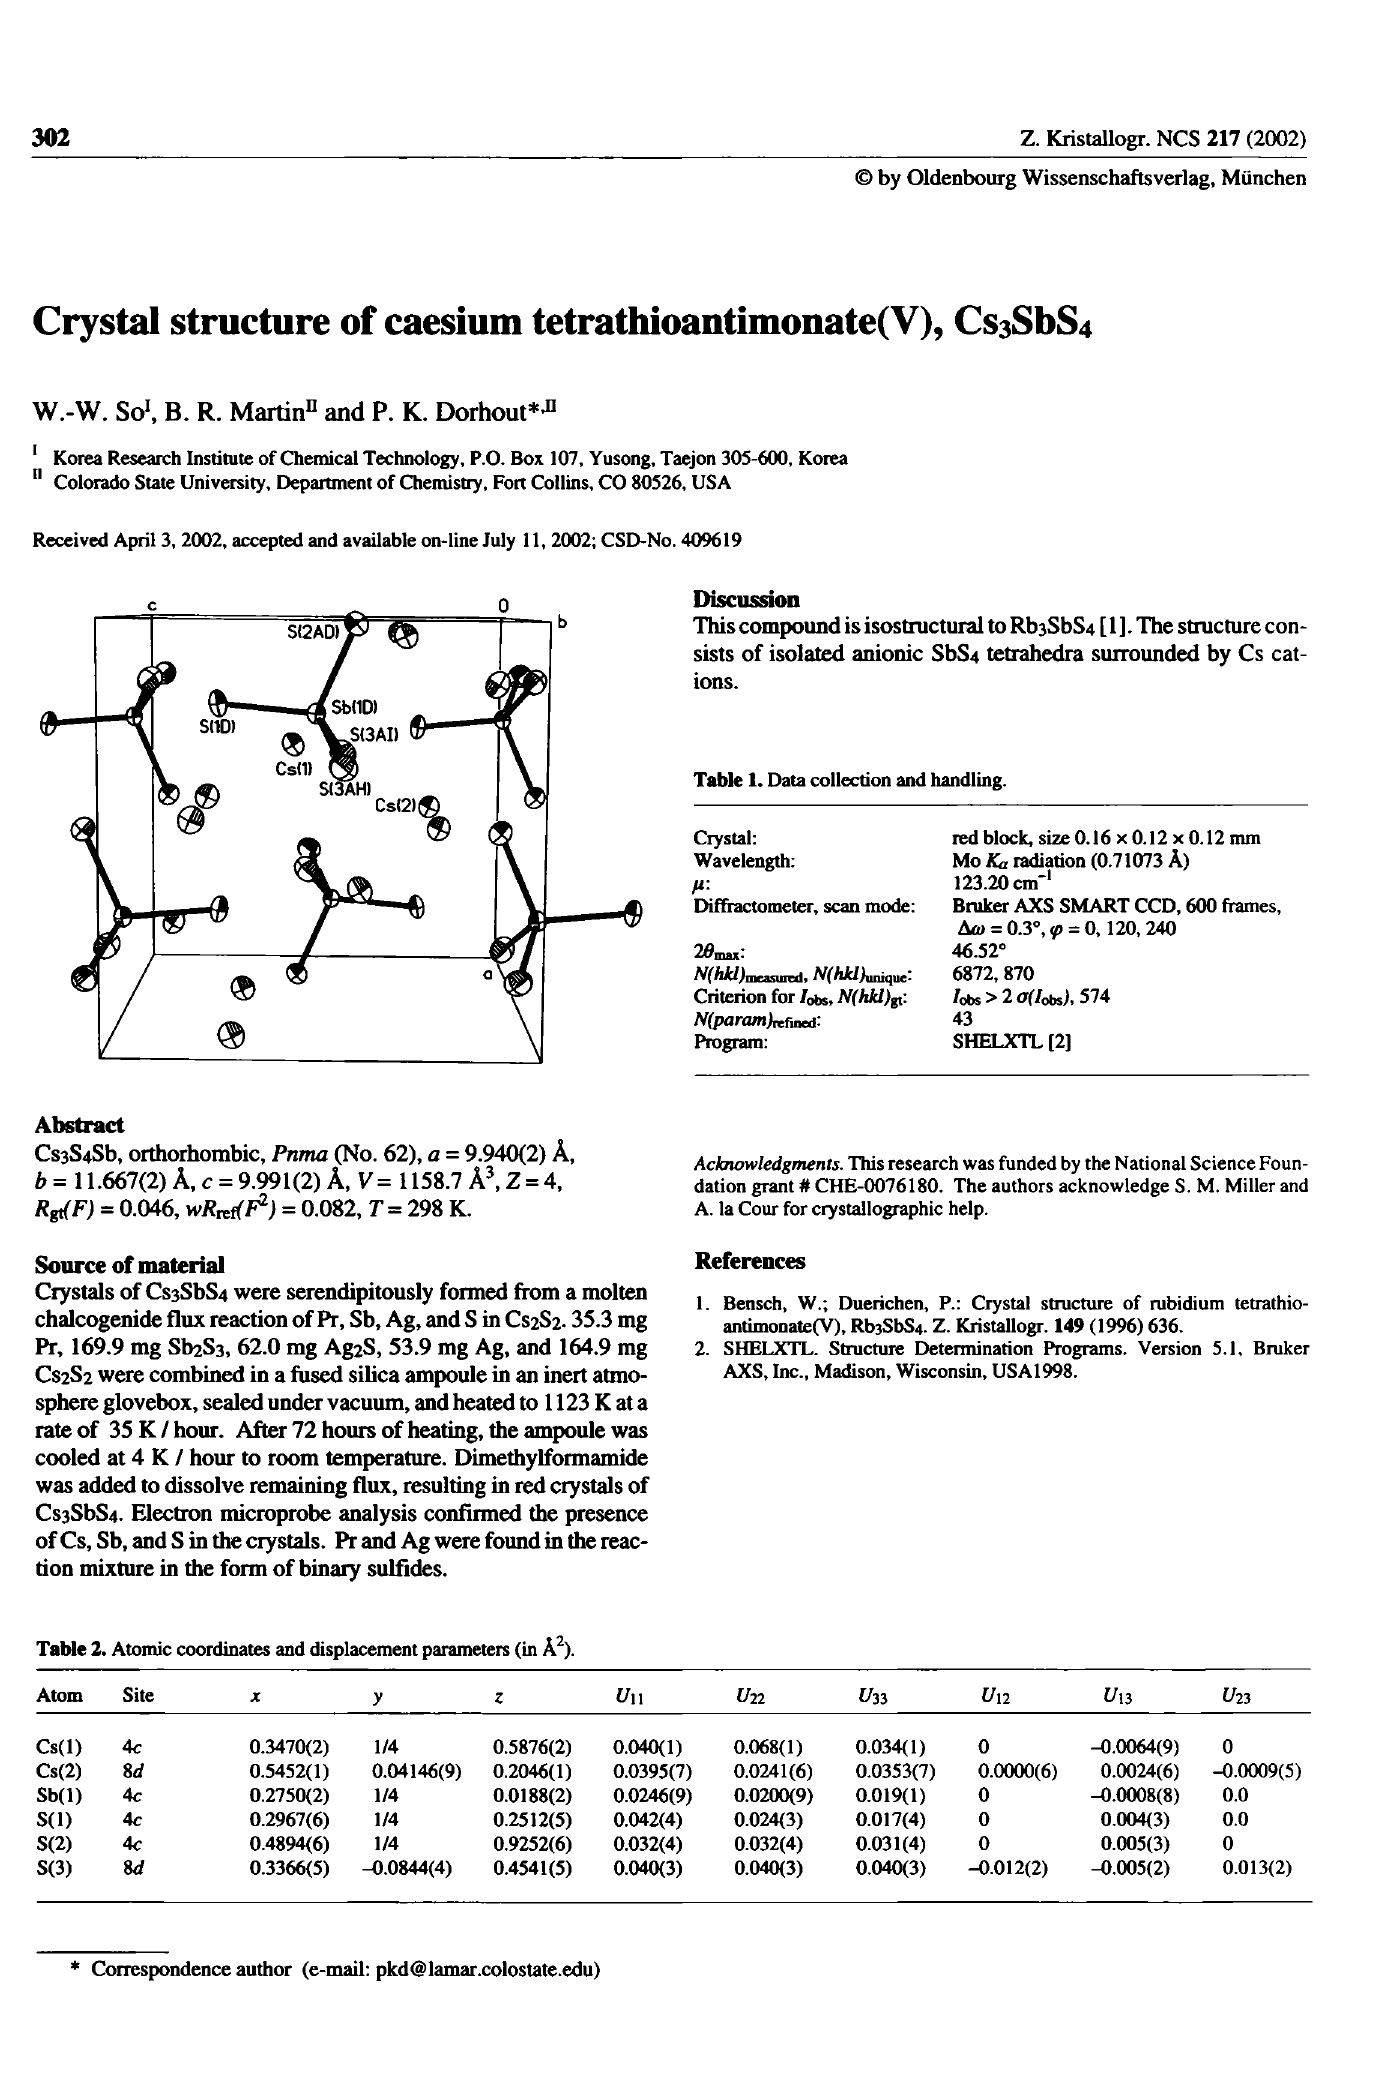
Table 1. Data collection and handling. Crystal: